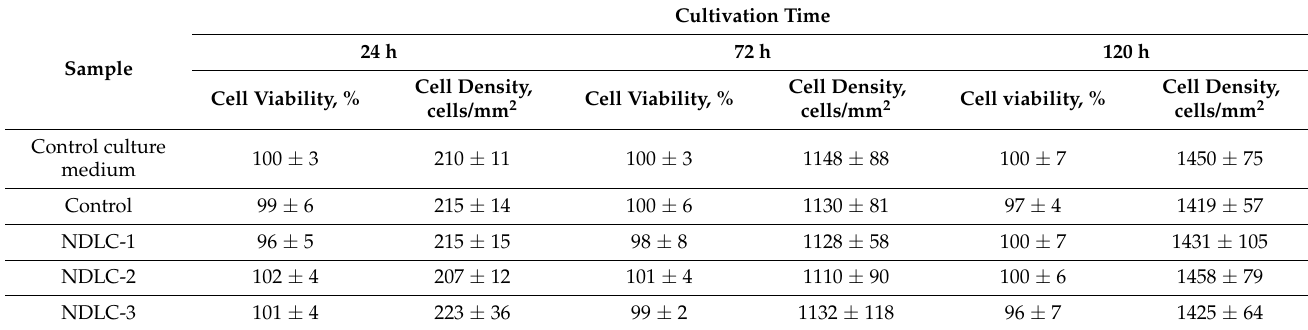
Table 3. Viability of fibroblasts during cultivation in extracts from fabricated